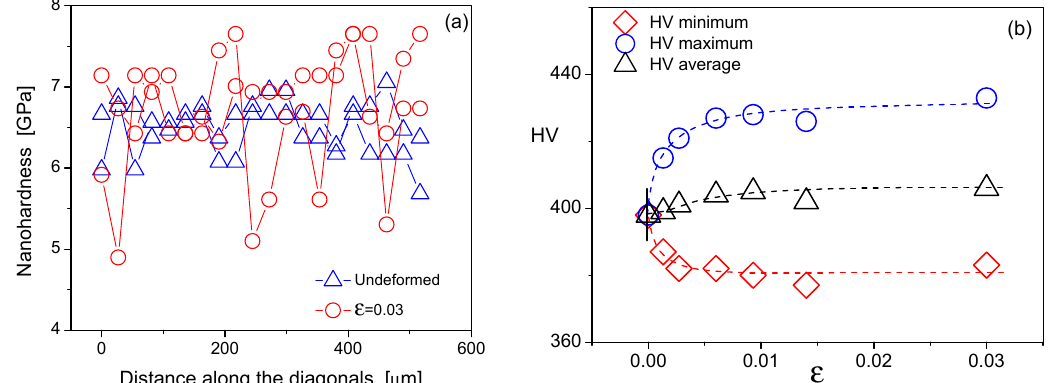
Figure 4. ( a ) Nanoharness values at steps of 25 µ m along the diagonals of the maps shown in Figure 3 for the undeformed (blue open up-triangles) and the ε = 0.03 tensile strained (red open circles) specimens. The means and standard deviations for the undeformed and the ε = 0.03 strained specimens are 6.50 ( ± 0.31) and 6.73 ( ± 0.70) GPa, respectively. ( b ) The mean, maximum, and minimum values of the Vickers-hardness distributions versus the ε true strain. The vertical thick black line indicates the statistical fluctuation of HV in the undeformed state.